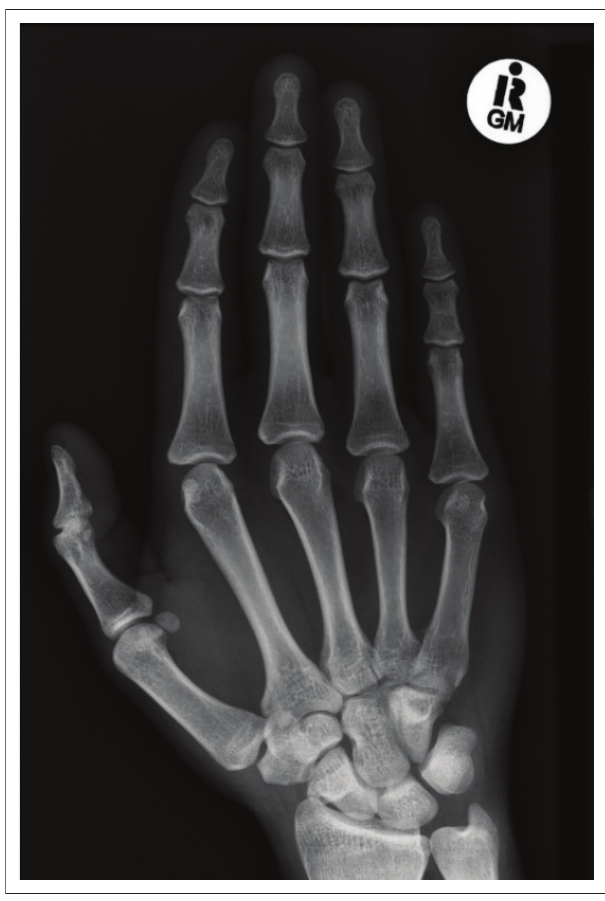
FIGURE 2: Digital hand-wrist radiograph (left) of a male subject with a chronological age of 15 years 10 months was matched to the GP standard image of a 14-year-old subject by both